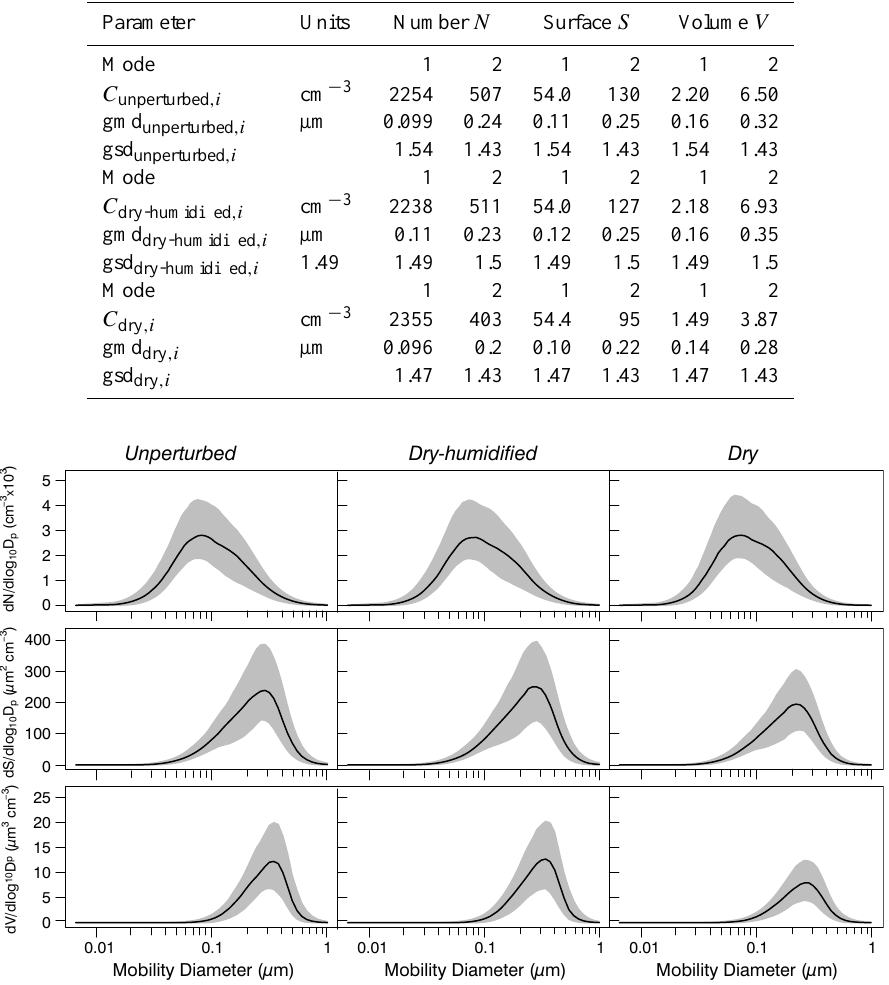
Figure 5. Summary number concentration (top row), surface area (middle row), and volume (bottom row) distributions for 3 June to 15 July 2013. The left panels indicate the unperturbed state, the middle panels the dry-humidified state, and the right panels the dry state. The central black lines show the median distribution, and the grey-shaded regions represent the interquartile range.